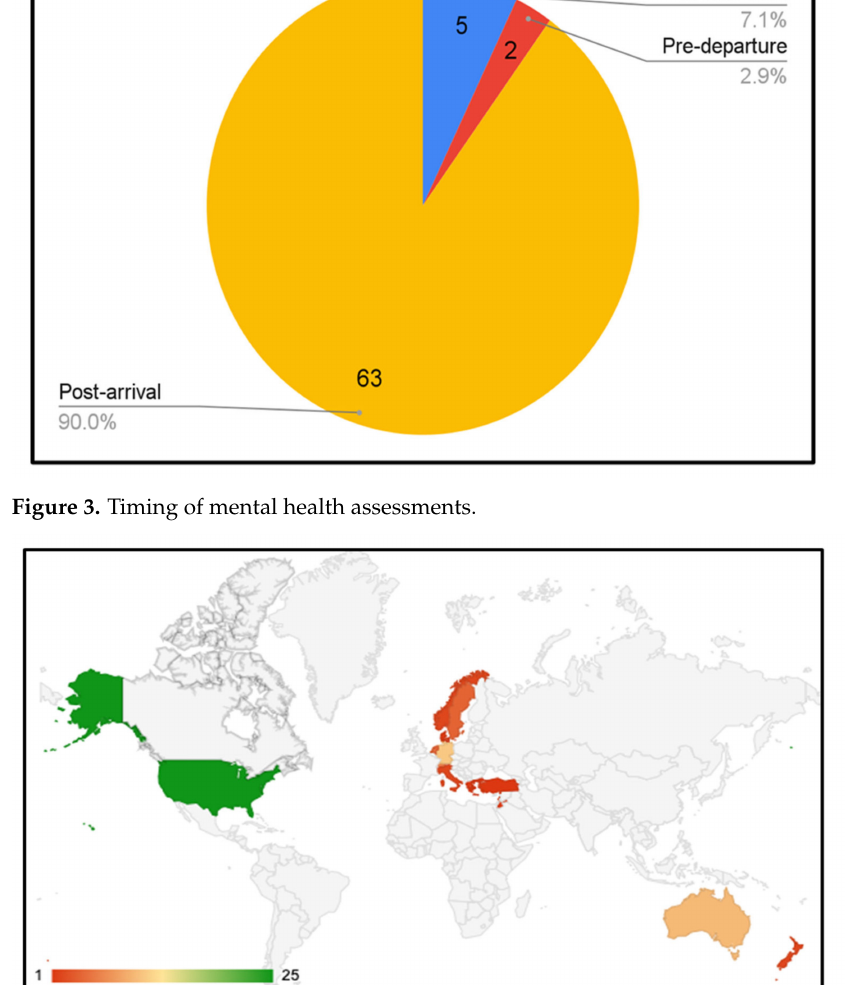
Figure 4. Global distribution of mental health assessments for refugees and asylum seekers according to setting of screening. To note: we identified one publication on pre-departure screening conducted in Lebanon prior to departure to the